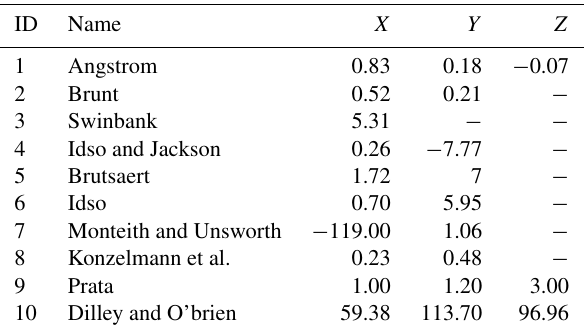
Table 2. Model parameter values as presented in their literature for- mulation.